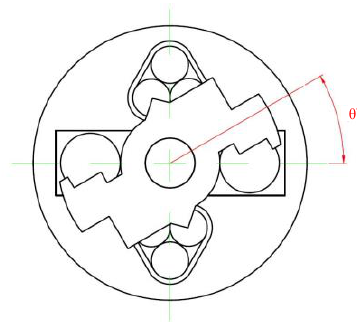
Figure 2. Coordinate and rotating angle of the single-phase switched reluctance motor.